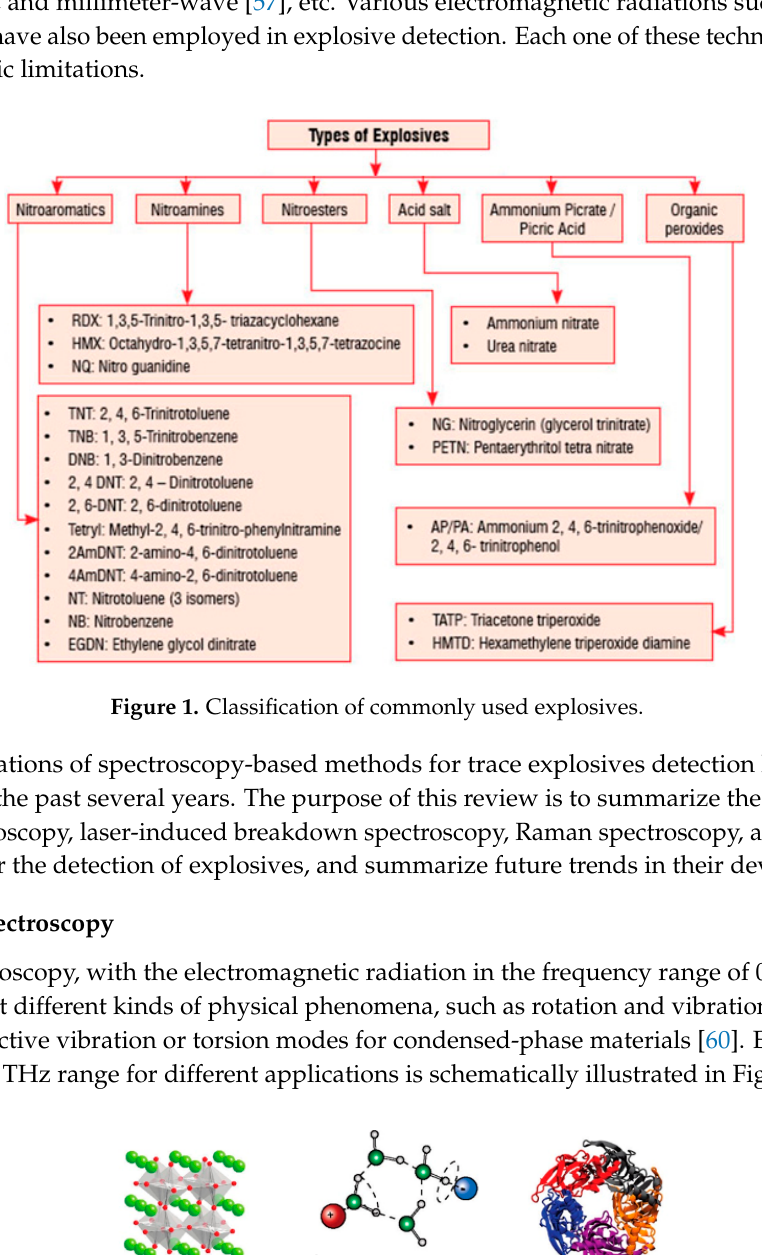
Figure 2. Electromagnetic spectrum in the THz range, with images highlighting the wide variety of molecules, materials, and phenomena that can be explored using THz spectroscopy. Adapted from [61], with permission from © 2011 American Chemical Society.